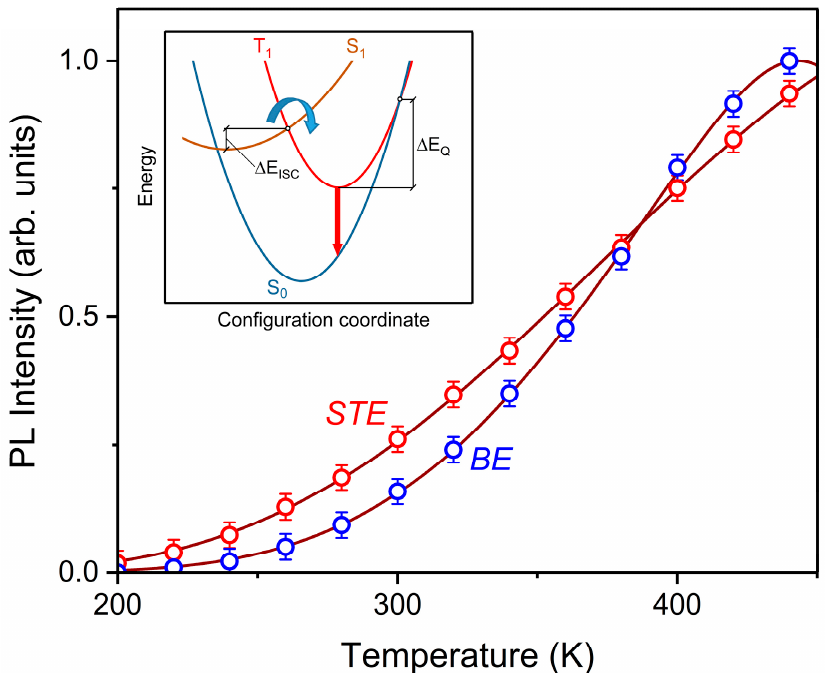
Figure 8. Normalized temperature dependences of emissions associated with self-trapped exciton ( STE ) and bound exciton ( BE ) in Y 2 O 3 film. The circles are experimental data, whereas the lines are approximated by Equation (8). The inset shows a configuration coordinate diagram explaining the meaning of the thermal activation barriers ∆ E ISC and ∆ E Q of the intersystem crossing and emission quenching.